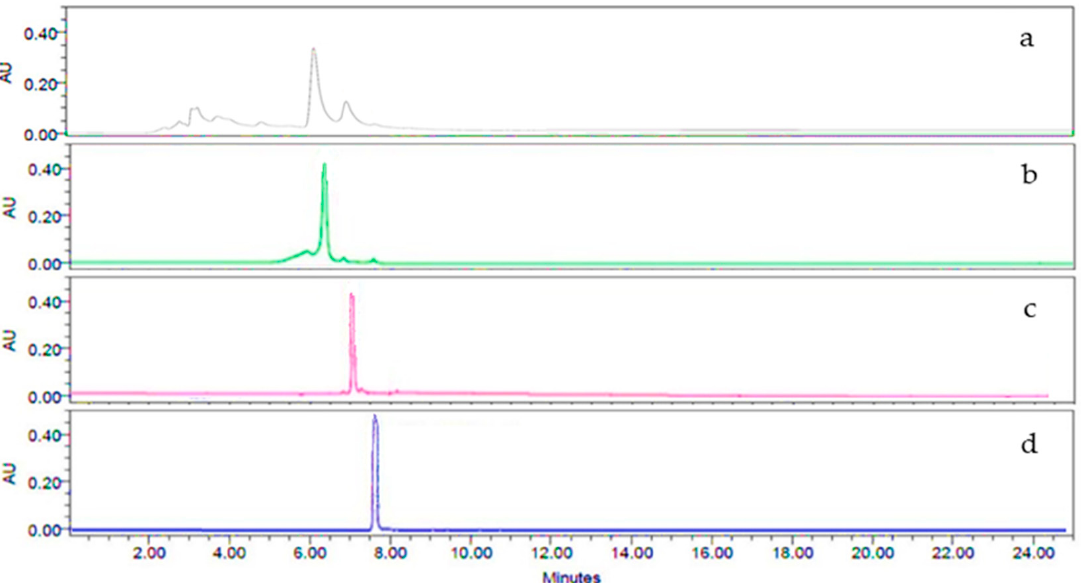
Figure 1. Representative high-performance liquid chromatography with diode array detection (HPLC-DAD) analysis at 254 nm of a sample of tea infusion extract of the leaves from Ac (IELAc) ( a ) and the flavonoid standards used rutin ( b ), narcissin ( c ), and nicotiflorin ( d